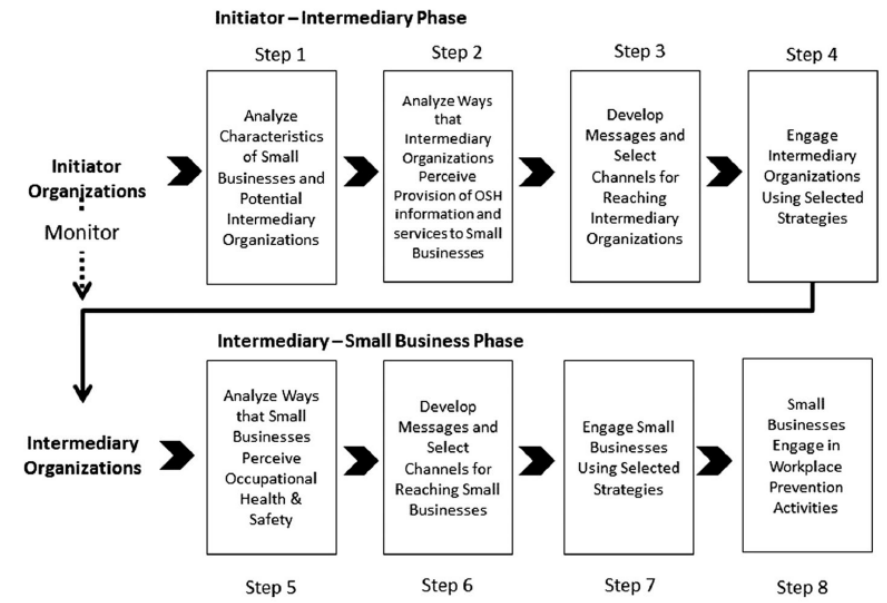
Figure 1. The intermediary–small business diffusion model.